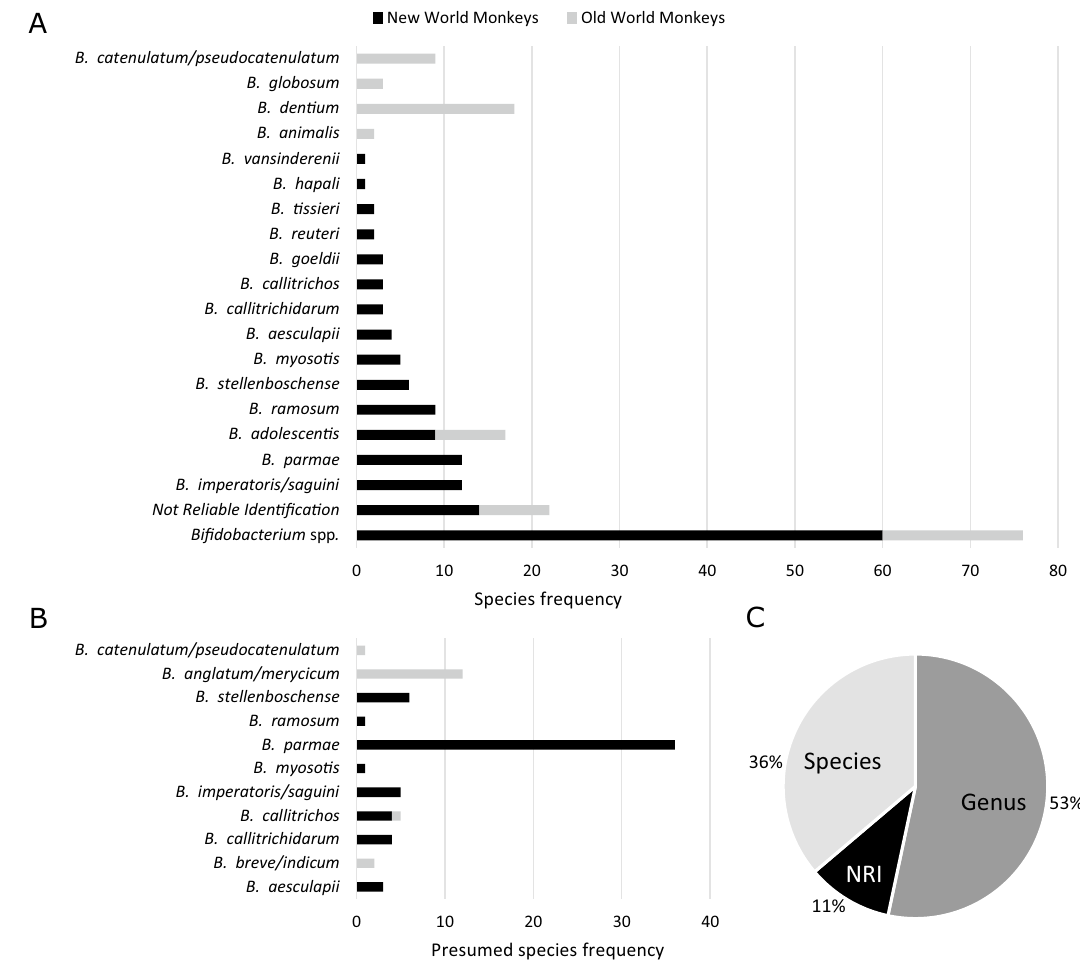
Figure 2. MALDI-TOF MS identification of primate bifidobacterial isolates. ( A) MALDI-TOF MS identification of 210 bifidobacterial strains. ( B) The closest probable species match of isolates with unambiguous genus MALDI-TOF MS identification ( Bifidobacterium spp). ( C) Proportion of species assignment, genus assignment and not reliable identification (NRI) of bifidobacterial isolates. Bruker criteria (scores)